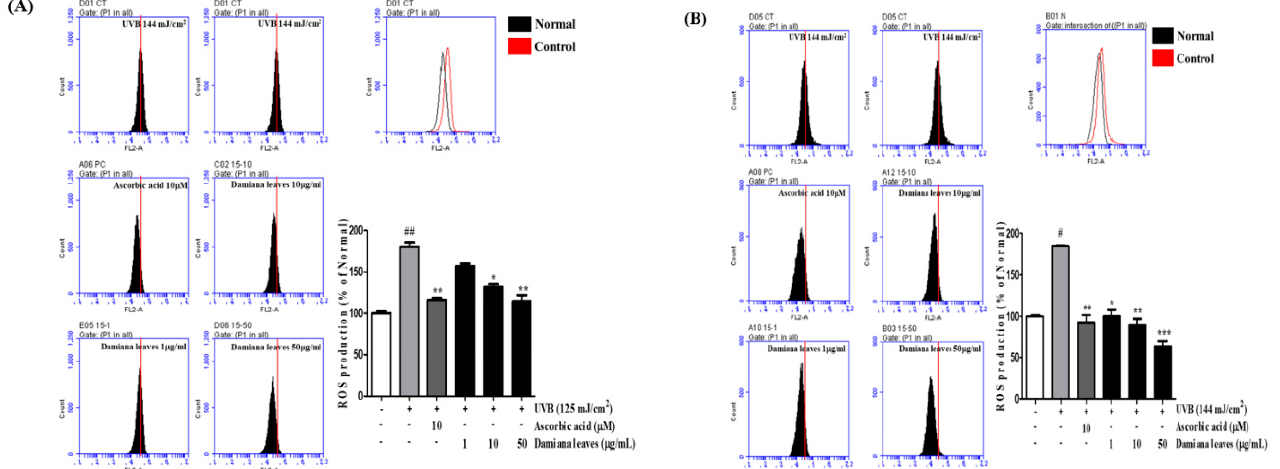
Figure 4. Effect of Damiana leaves extract on levels of intracellular reactive oxygen species (ROS) in UVB-irradiated HaCaT ( A ) and HDF ( B ) cells. After 24 h of treatment, intracellular ROS level was measured. The number of cells is plotted versus the dichlorofluorescein fluorescence detected by the FL-2 channel; results presented as histograms. Data are presented as the mean ± SD. # and * indicate significant differences from the non-irradiated control and UVB-treated groups, respectively. # p < 0.05 and ## p < 0.01 vs. the non-treated group. *, ** and *** p < 0.05, 0.01, and 0.001 vs. the UVB-treated control, respectively.